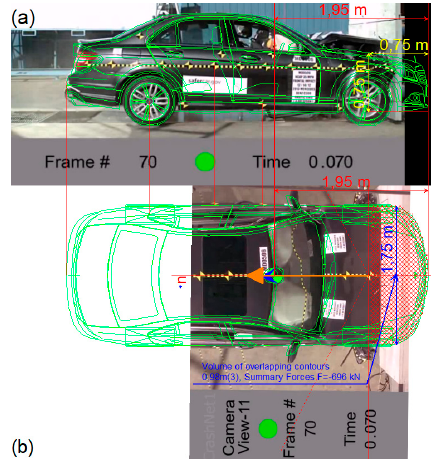
Figure 10. Test and simulation depth of deformations in the final compression phase t = 70 ms, side view ( a ) and top view ( b ).